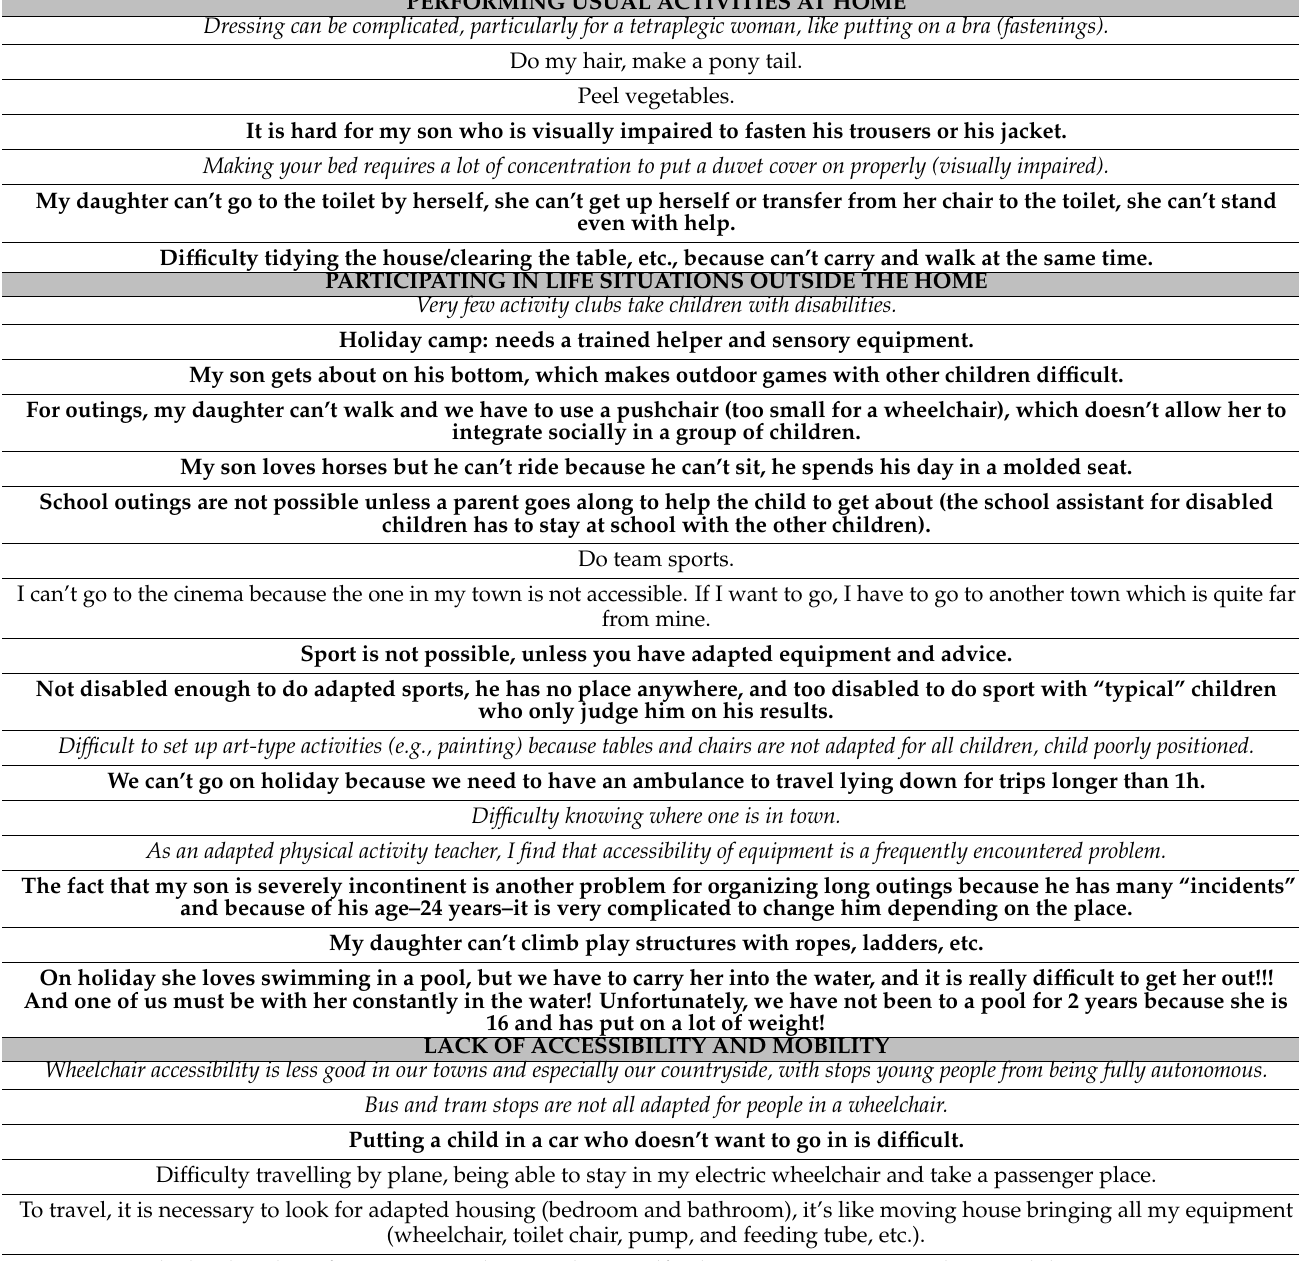
Table 4. Examples of experienced difficulties described in the responses to open questions (in bold style: responses from relatives; in italic style: responses from professionals; in regular style: responses from children and youth with